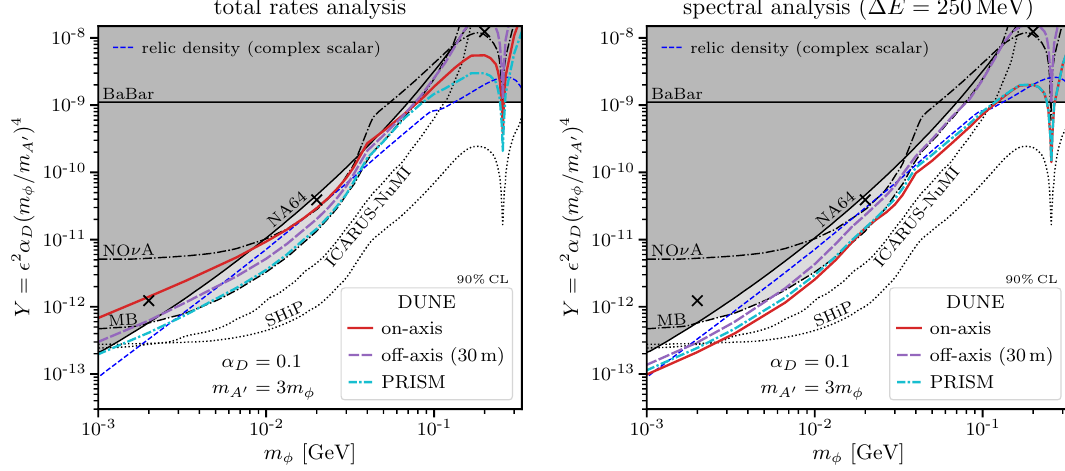
Figure 3 . Expected upper exclusion limits for the dark photon model, assuming a total DUNE- PRISM running time of 5 years ( 5 . 5 × 10 21 pot) in neutrino mode. We compare results for on- axis-only running (red solid), off-axis-only running (purple dashed), and a realistic DUNE-PRISM strategy with equal amounts of data taken at seven different locations (cyan dot-dashed). The left panel corresponds to a total rates (cut & count) analysis as in ref. [13], while the analysis in the right panel includes spectral information. Gray shaded regions indicate existing limits on the model, while dotted black lines show projections for other future experiments. Black crosses indicate the exemplary model parameter points presented in figure